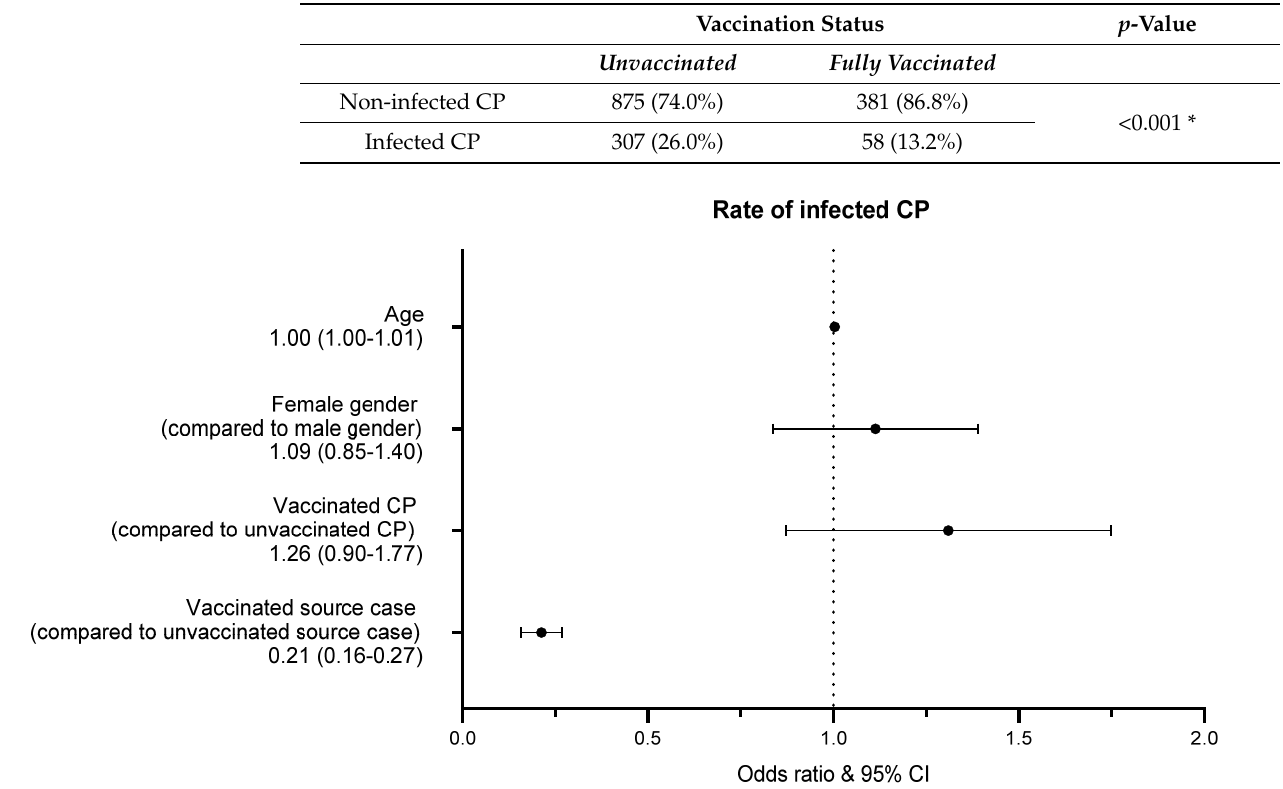
Figure 4. Factors influencing transmission of CPs; binary logistic